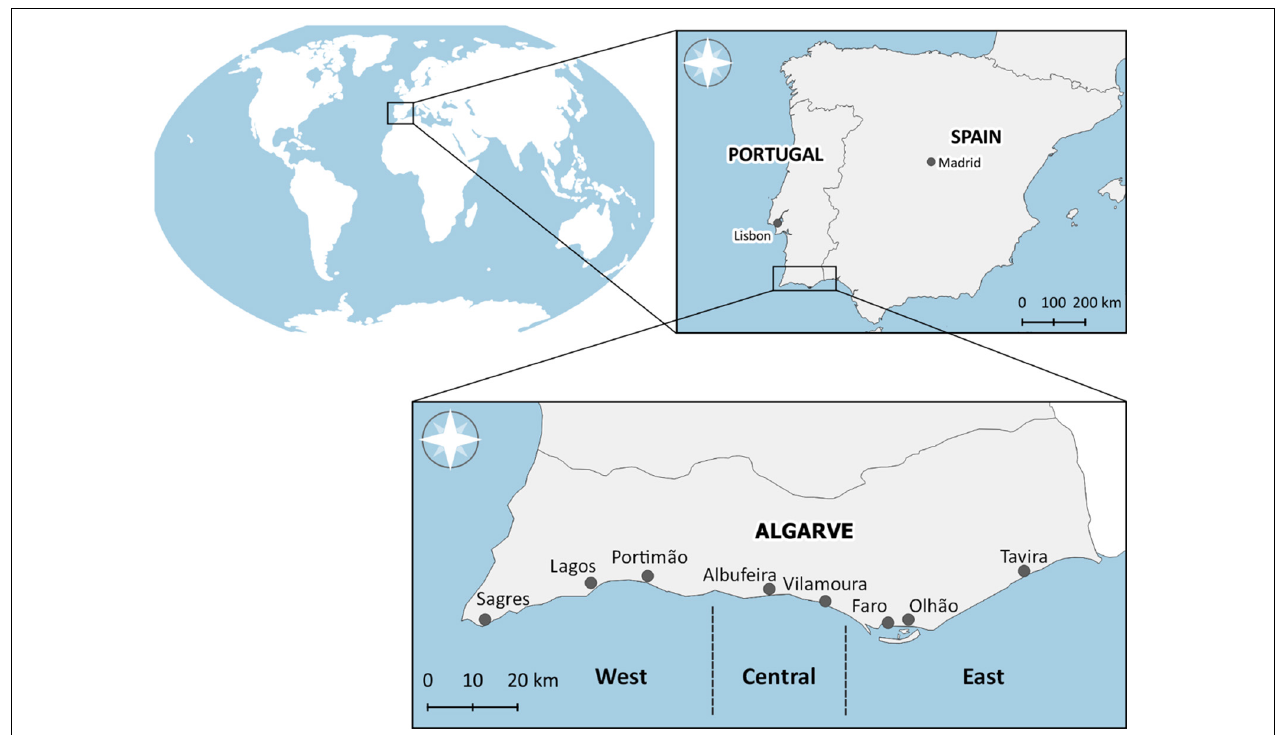
FIGURE 1 | Main cities and villages along the coast of the Algarve (Portugal, Europe) where the whale-watching companies analyzed in this study are located (see Table 1 for